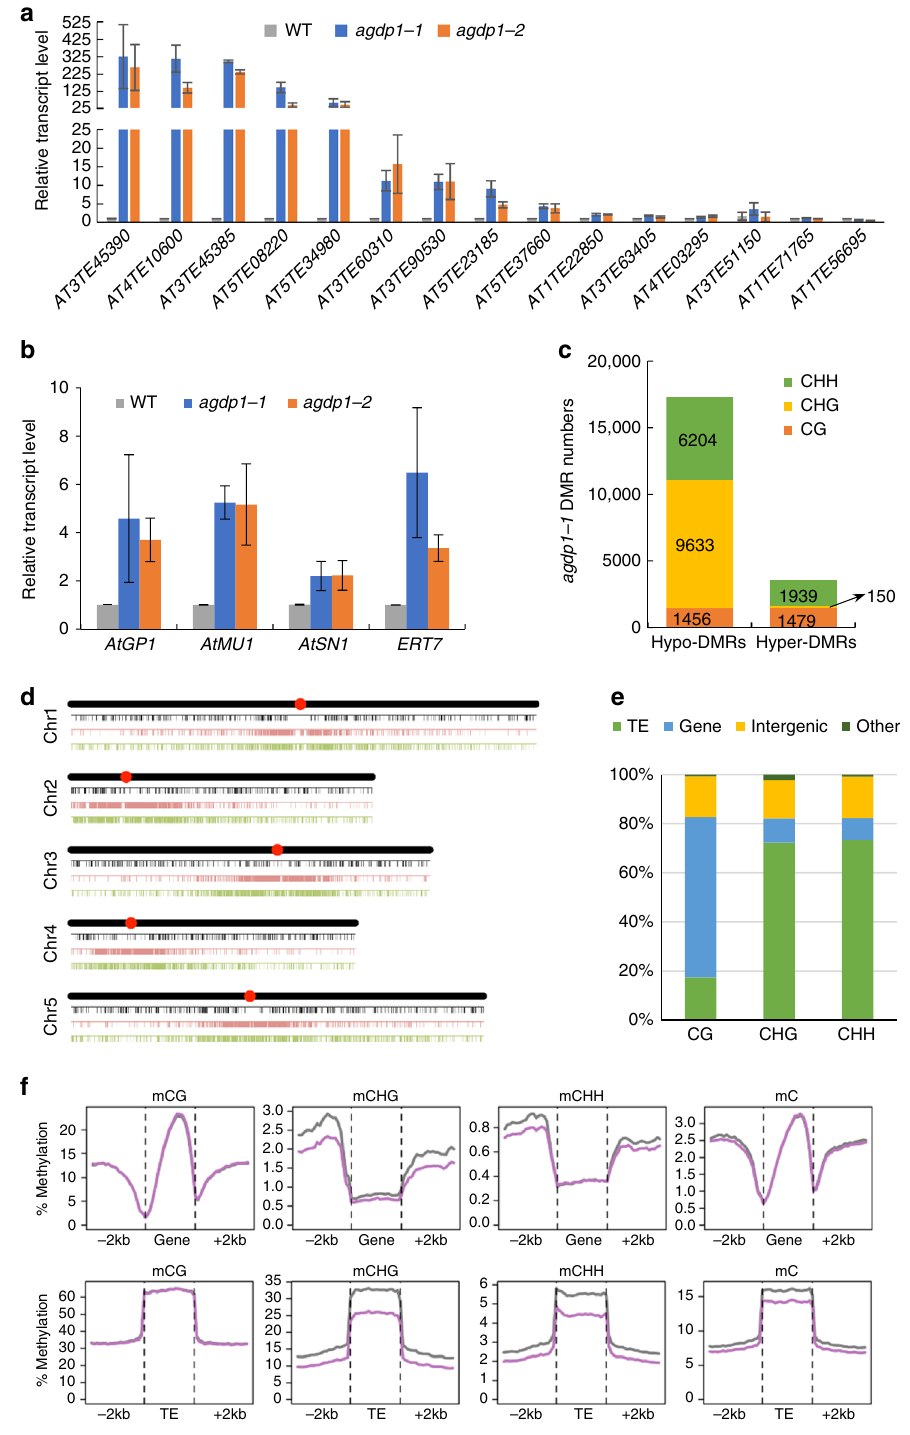
Fig. 4 AGDP1 contributes to transcriptional silencing and non-CG methylation at some loci. a The transcript levels of the indicated TEs were determined by quantitative RT-PCR in the wild-type, agdp1-1 , and agdp1-2 . Error bars are SDs of three biological replicates. b The RNA transcripts of AtMU1 , AtGP1 , AtSN1 , and ERT7 were detected by quantitative RT-PCR in the wild-type, agdp1-1 , and agdp1-2 . Error bars are SDs of three biological replicates. c The numbers of CG, CHG, and CHH hypo-DMRs and hyper-DMRs identi fi ed in agdp1-1 . d The distribution of hypo-DMRs throughout the fi ve chromosomes. Black, pink, and green bars represent CG, CHG, and CHH hypo-DMRs, respectively. Red circles indicate centromeres. e Composition of the genomic location of the hypo- DMRs. TE, transposable element. f Average DNA methylation levels along protein-coding genes (upper) and TEs (lower) and the 2-kb fl anking regions in different cytosine contexts. Gray and pink curves represent DNA methylation levels of wild-type and agdp1-1 ,